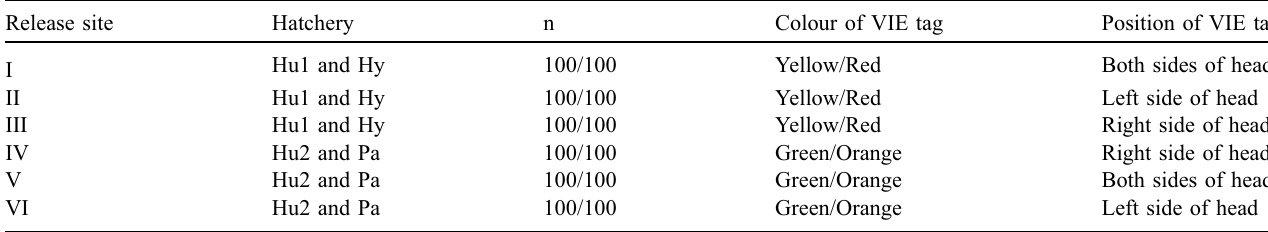
Table 1. Number of grayling released at each site and